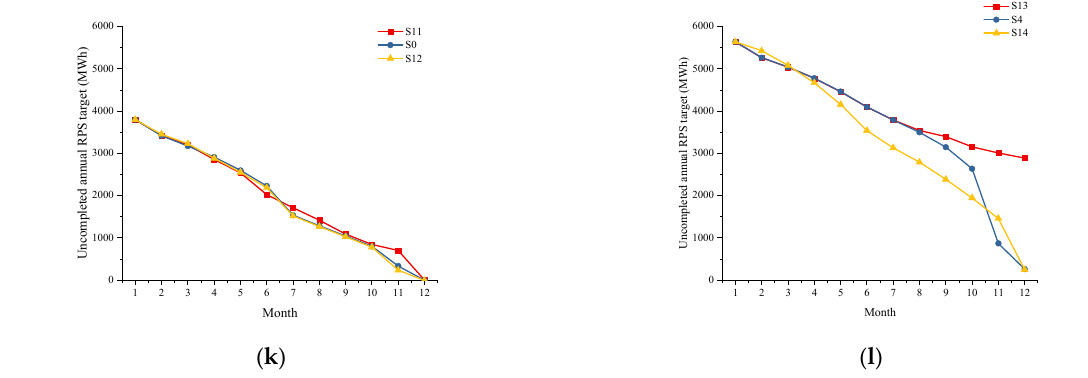
Figure 10. Trends of decision-making and market performance under different penalties. ( a ) Accumulative renewable-power trading volume (RPS weight = 13%). ( b ) Accumulative renewable-power trading volume (RPS weight = 19%). ( c ) Monthly renewable-power trading volume (RPS weight = 13%). ( d ) Monthly renewable-power trading volume (RPS weight = 19%). ( e ) TGC price (RPS weight = 13%). ( f ) TGC price (RPS weight = 19%). ( g ) Accumulative TGC trading volume (RPS weight = 13%). ( h ) Accumulative TGC trading volume (RPS weight = 19%). ( i ) Accumulative unsold TGCs (RPS weight = 13%). ( j ) Accumulative unsold TGCs (RPS weight = 19%). ( k ) RPS target completion (RPS weight = 13%). ( l ) RPS target completion (RPS weight = 19%). Table 4. Scenarios for analyzing the impacts of